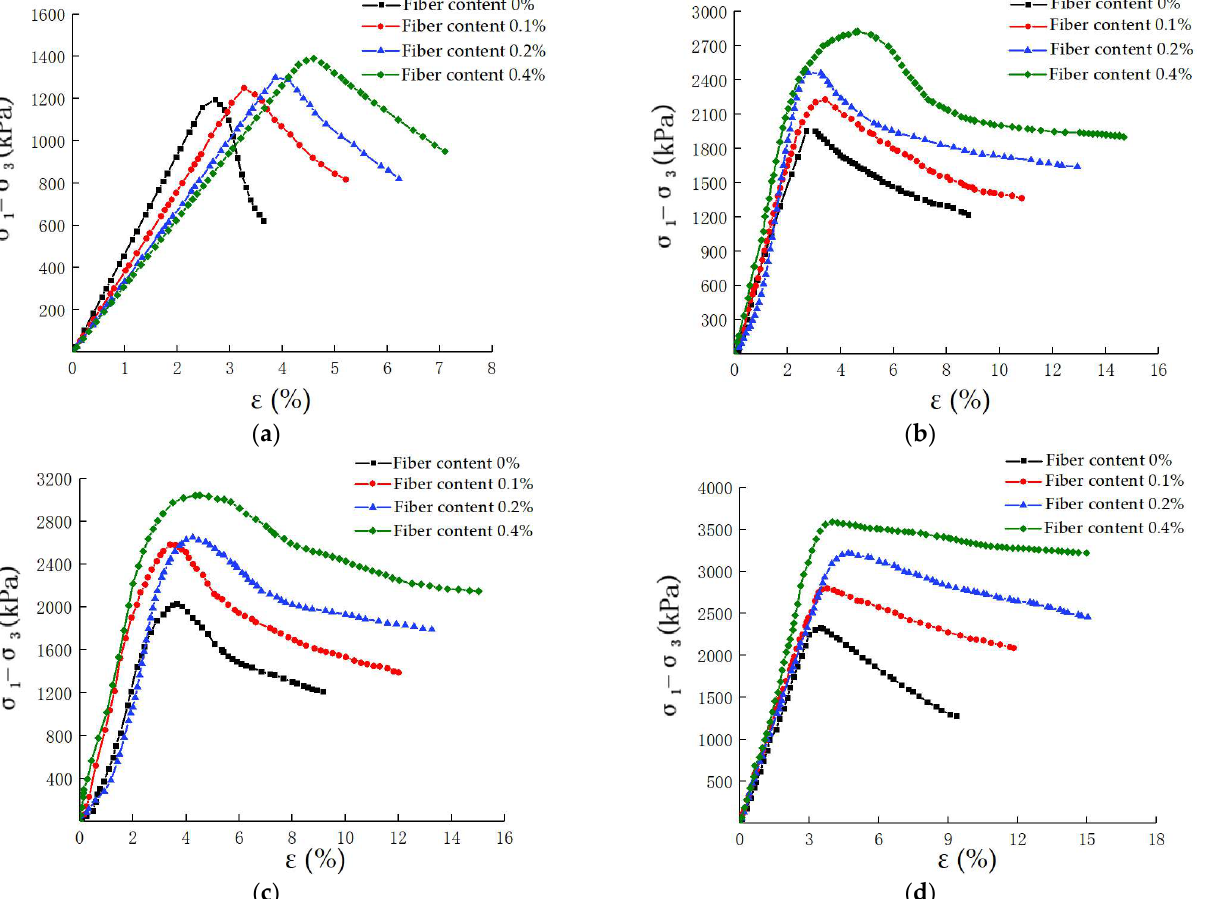
Figure 5. Stress-strain curves of fiber-cement soil under different confining pressures. ( a ) confining pressure 0 kPa; ( b ) confining pressure 100 kPa; ( c ) confining pressure 200 kPa; ( d ) confining pressure 400 kPa.